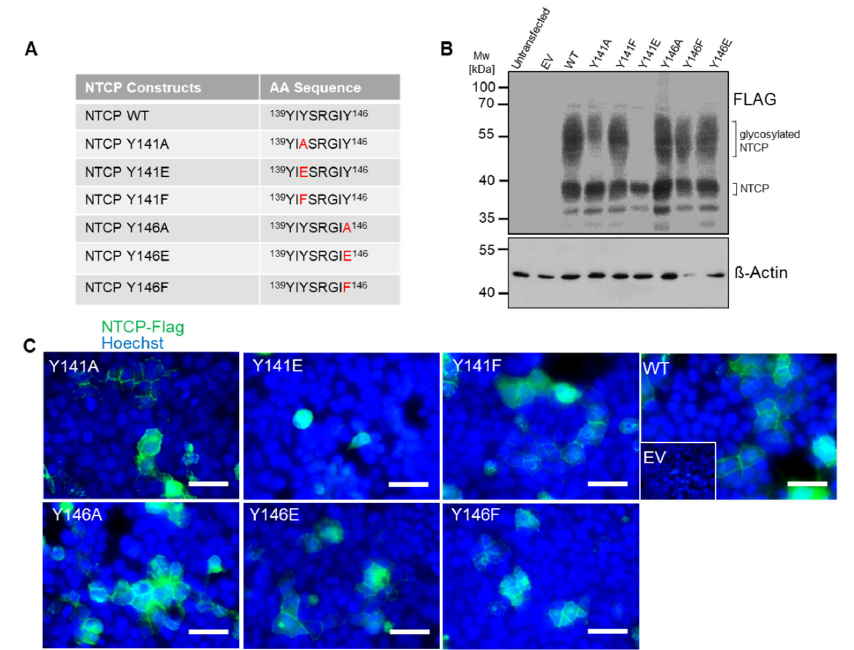
Viruses 2022 , 14 , x FOR PEER REVIEW Figure 3. Relevance of tyrosine residues 141 and 146 for the transporter and virus receptor functions of human NTCP. ( A ) List of generated NTCP mutants with the substituted amino acid residues marked in red. ( B ) Protein expression of the NTCP wt and mutants in HEK293 cells was demonstrated by Western blotting using an anti-FLAG antibody. Expression of beta-actin served as loading control. MW, molecular weight; EV, empty vector. ( C ) Microscopy pictures of HEK293 cells overexpressing the NTCP mutant proteins. NTCP expression was detected using primary rabbit anti-FLAG and Alexa Fluor 488-labelled goat anti-rabbit secondary antibodies (green). Nuclei were stained by Hoechst 33342 (blue). Scale bars: 40 µm. All data are representative of three independent experiments.